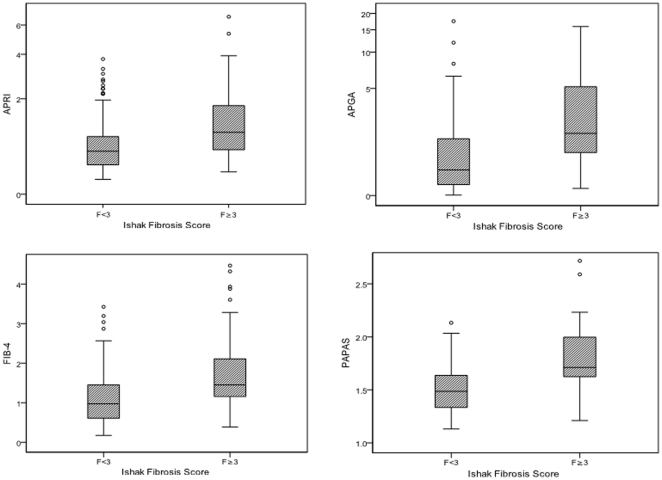
Model values based on Ishak fibrosis score.The top and bottom of each box represents the 25th and 75th percentile interval, the line through the box in the median and the error bars are the 5th and 95th percentile intervals.